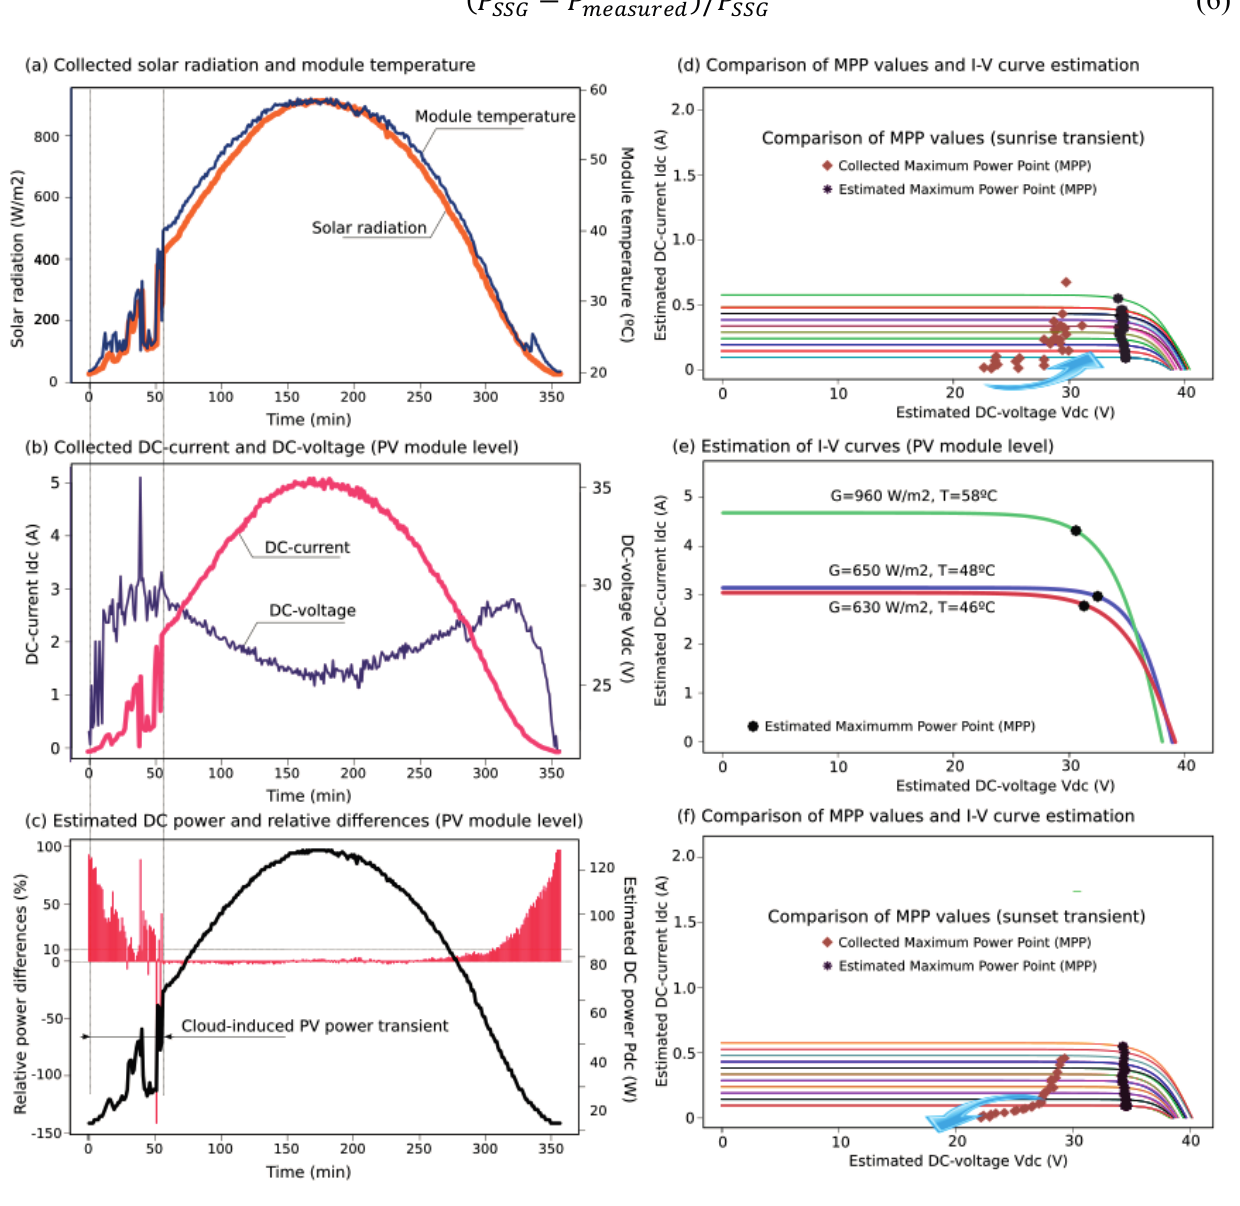
Figure 13. Case Study I: collected data ( a , b ); estimations of DC power ( c ); and I - V curves at the PV module level ( d – f